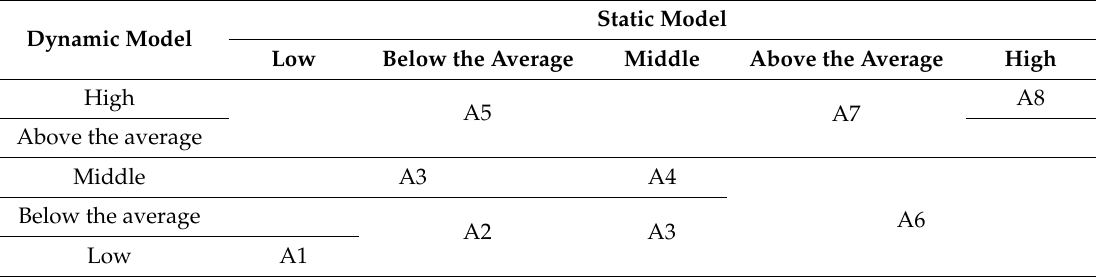
Table 9. An interpretation map for the formation of a comprehensive assessment based on the values of the integral indicator obtained using static and dynamic * models. Static Model Dynamic Model Low Below the Average Middle Above the Average High High A5 A7 Above the average Middle A3 A4 A6Below the